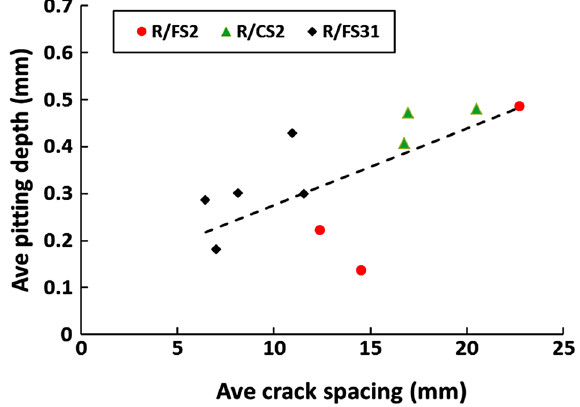
Fig. 16 Influence of average crack spacing in average pitting depths in steel bar.